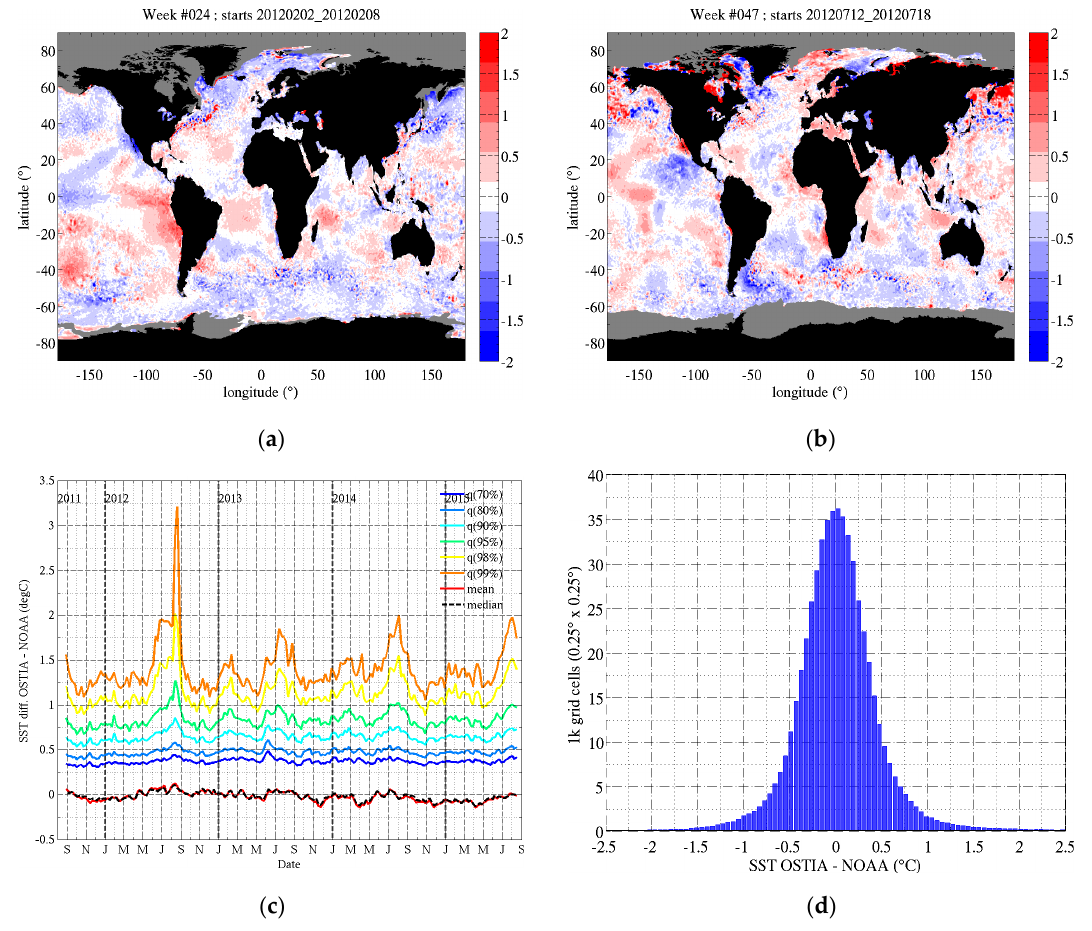
Figure 5. Differences in weekly average SST between OSTIA and National Oceanic and Atmospheric Administration (NOAA) OI V2 products. Difference maps are averaged weekly from daily products at 0.25° resolution in latitude/longitude during the period September 2011–August 2015. The top row ( a , b ) shows two examples of SST differences maps. The dates are chosen to show examples of ( a ) smaller (Feb 2012) and ( b ) larger (July 2012) differences in SST. Grey areas report sea ice fraction (from OSTIA) of 0.15 or above. The temporal evolution of SST differences is reported in panel ( c ) through several statistical indicators. The curves report the time series of (red) mean and (dashed ‐ black) median difference in global weekly maps and the percentiles of the absolute value of the SST differences between 70% and 99% (see text in Section 3.2). Panel ( d ) reports the histogram of SST difference for the map reported in ( b ) (y ‐ axis unit is 1,000 grid cells).